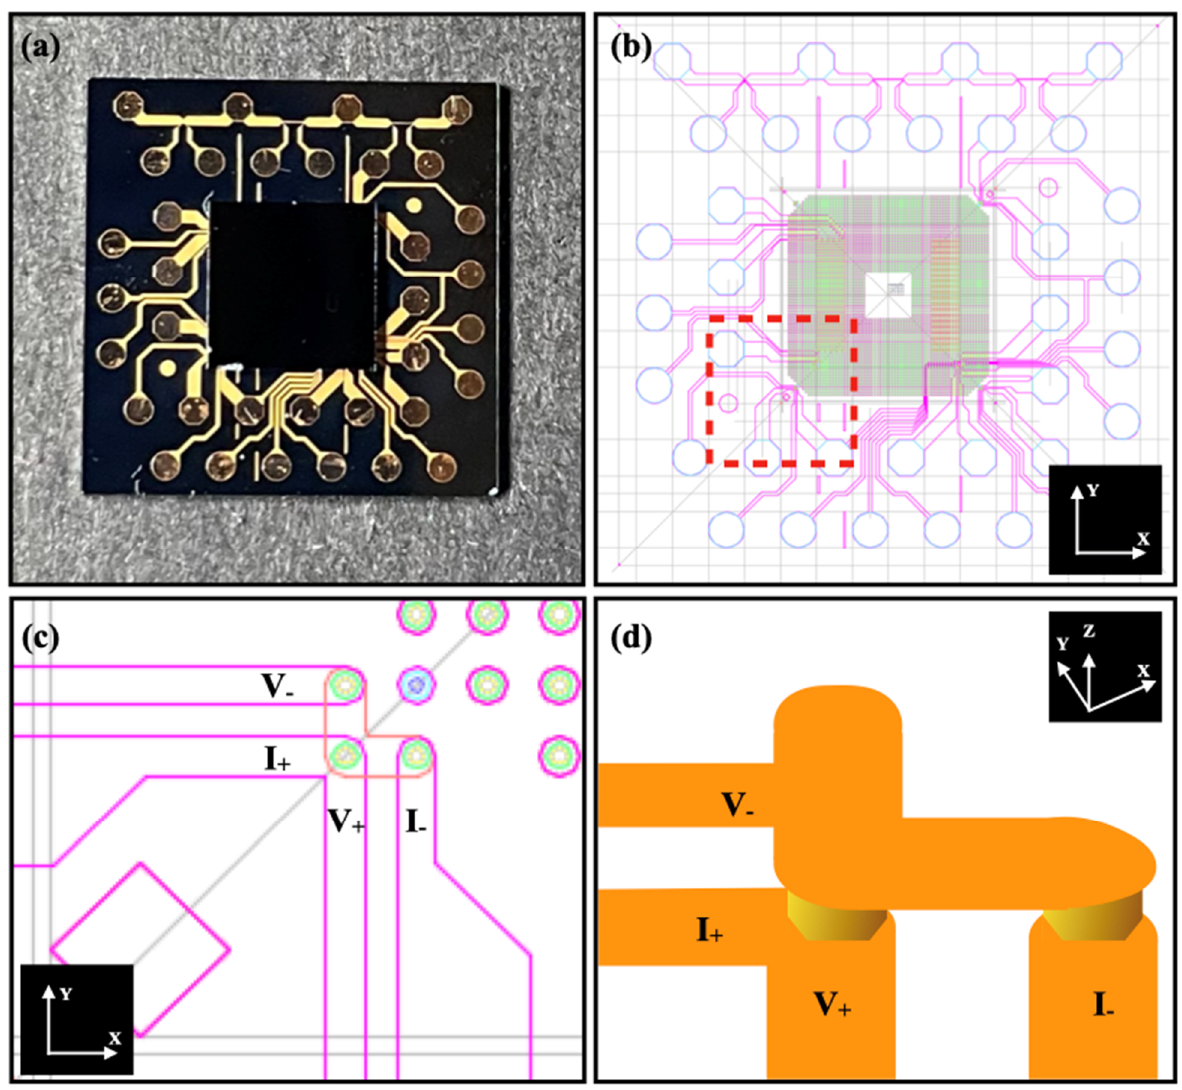
Figure 1. ( a ) Bonded test vehicle. ( b ) Layout of the tested vehicle. ( c ) Enlarged layout of the Kelvin structure at squared area at ( b ). ( d ) Schematic of the Kelvin structure in the tested vehicle.